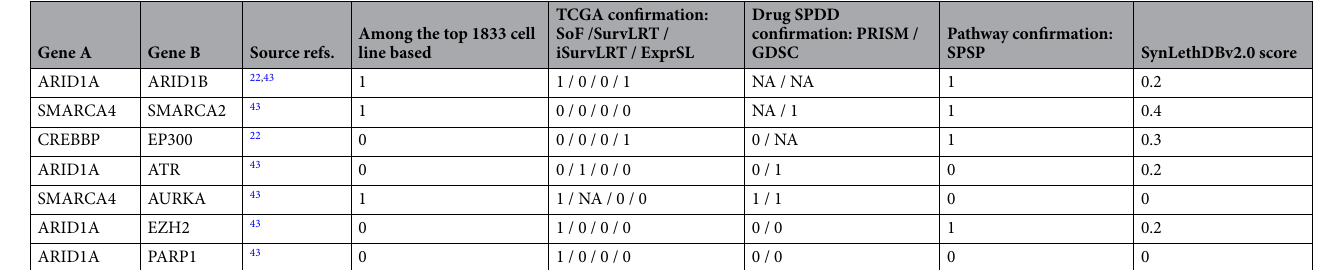
Table 2. Paralogs and known SL pairs in SWI/SNF. Confirmation in each test is in accordance with the SL evidence criteria described in “Methods”. 1 confirmed; 0 not confirmed; NA test could not be